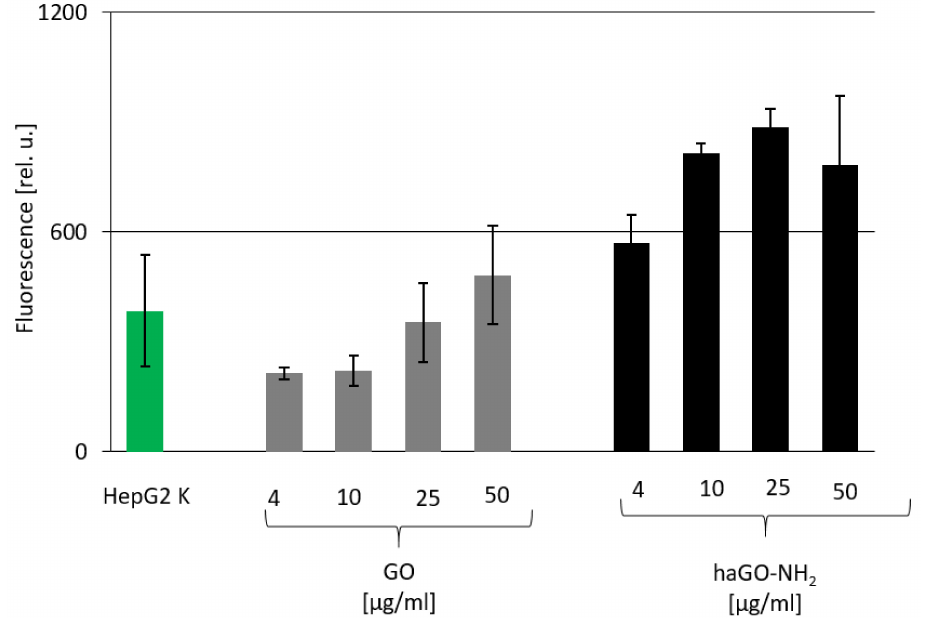
Figure 5. ROS production in HepG2 cells after treatment with GO nanoparticles. The production of intracellular ROS was measured using 2,7-dichlorofluorescin diacetate. HepG2 cells were seeded in 24-well plates and allowed for adherence. The fluorescence intensity of DCF was detected on a spectrofluorometer upon excitation at 485 nm and emission at 520